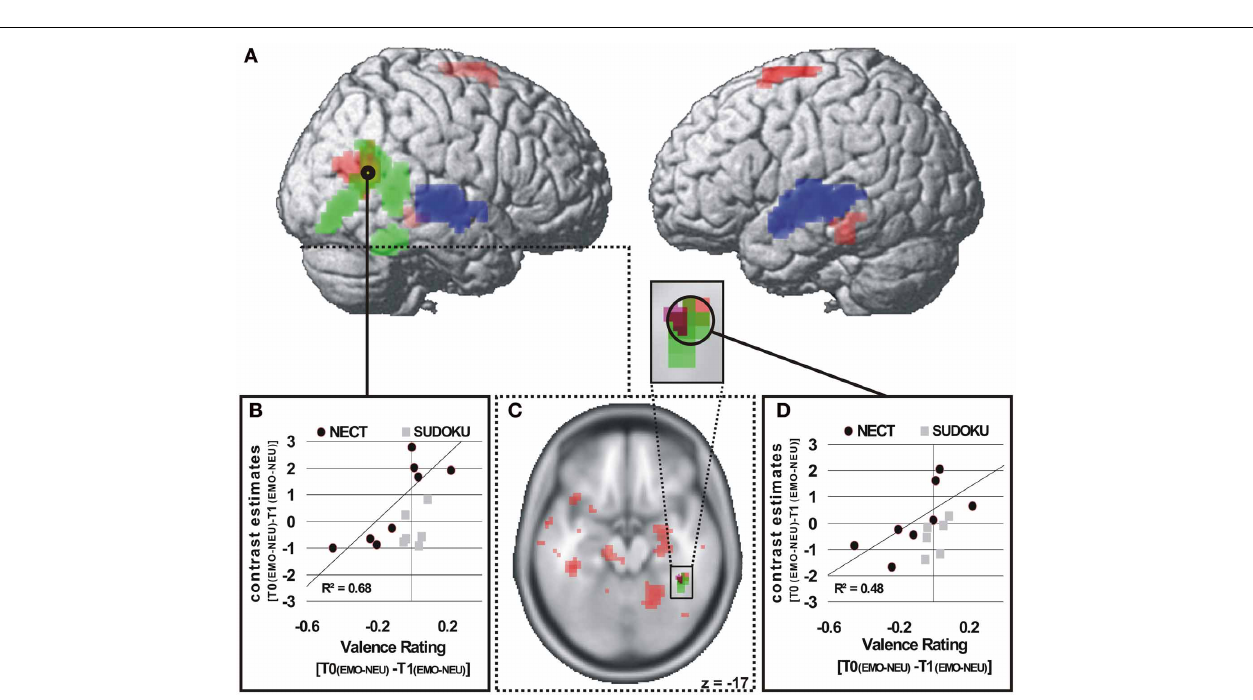
in the NECT group and a non-significant association in the SUDOKU group in the right STS face area (A,B) and in the right FFA (C,D) . Voice-selective areas (blue) and face-selective areas (green), p < 0 . 0001, uncorrected, p < 0 . 05 FWE whole-brain-corrected at cluster